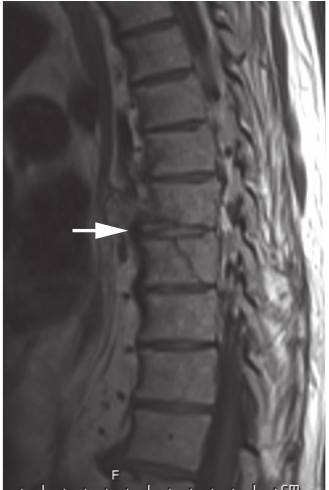
Figure 4: Sagittal MRI, T1 sequence, showing the T8-T9 fractures involving the anterior and middle columns with widening of the anterior disc space ( arrow ).